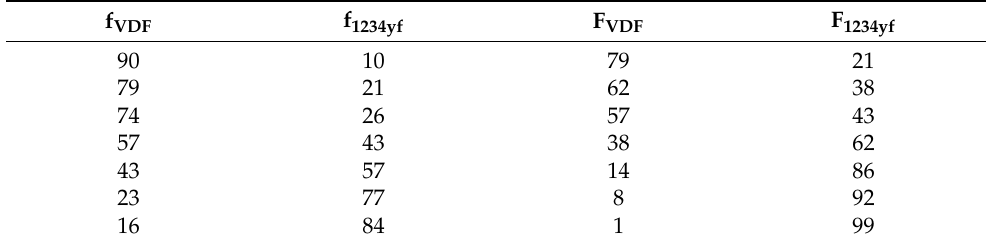
Figure 4. Stack of 19 F NMR spectra recorded at 25 °C in (CD 3 ) 2 CO of seven P(VDF- co -1234yf) copolymers. The polymerizations were stopped at low monomer conversion (<10%). Table 2. Compositions of the feed (f, mol fraction) and composition (F, mol fraction) in the P(VDF- co - 1234yf)